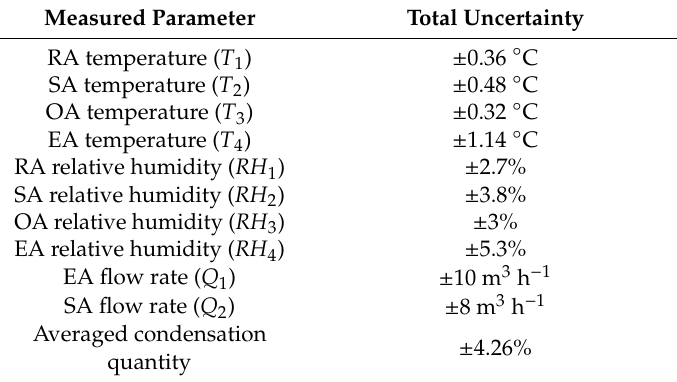
Table 3. Total uncertainties of measured parameters.